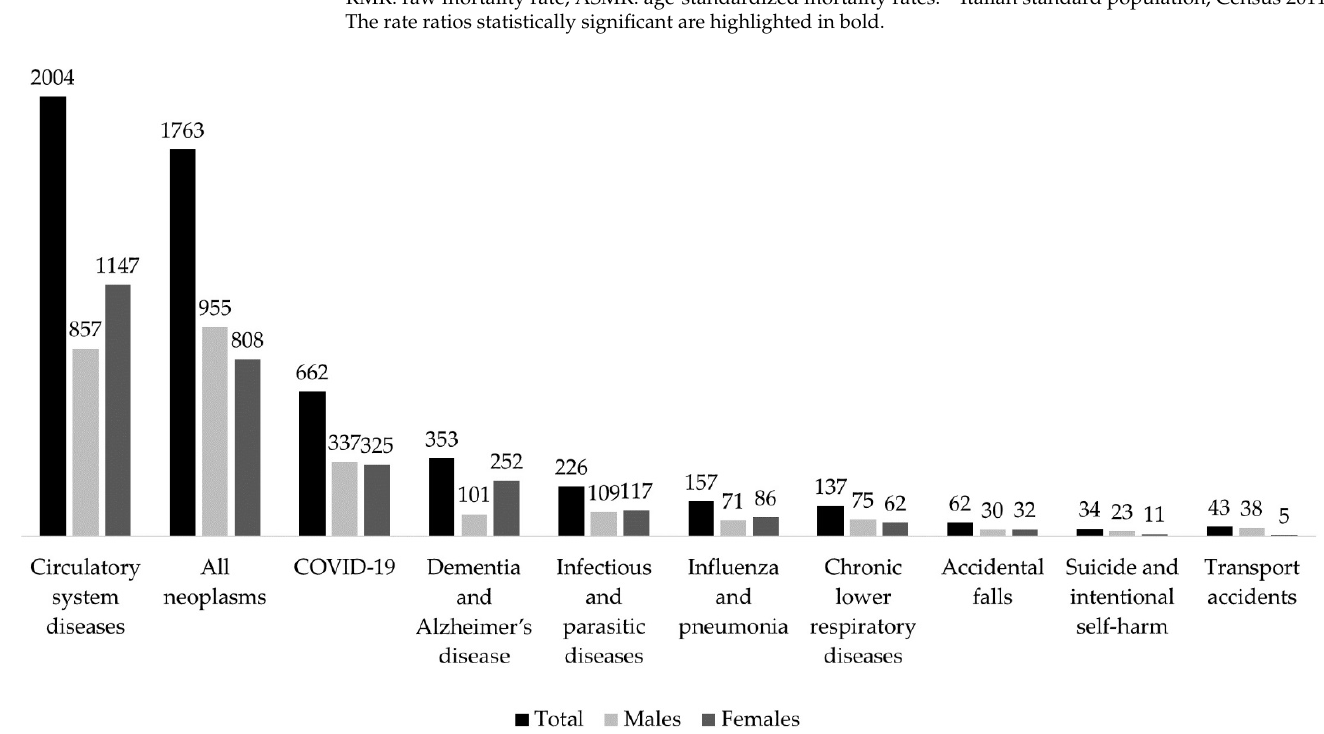
Figure 1. Bar plots with number of certified deaths from the first ten causes, registered in 2021, ordered from the highest to the lowest numbers, in the total, males and females population. Pavia province, Lombardy region, Italy.